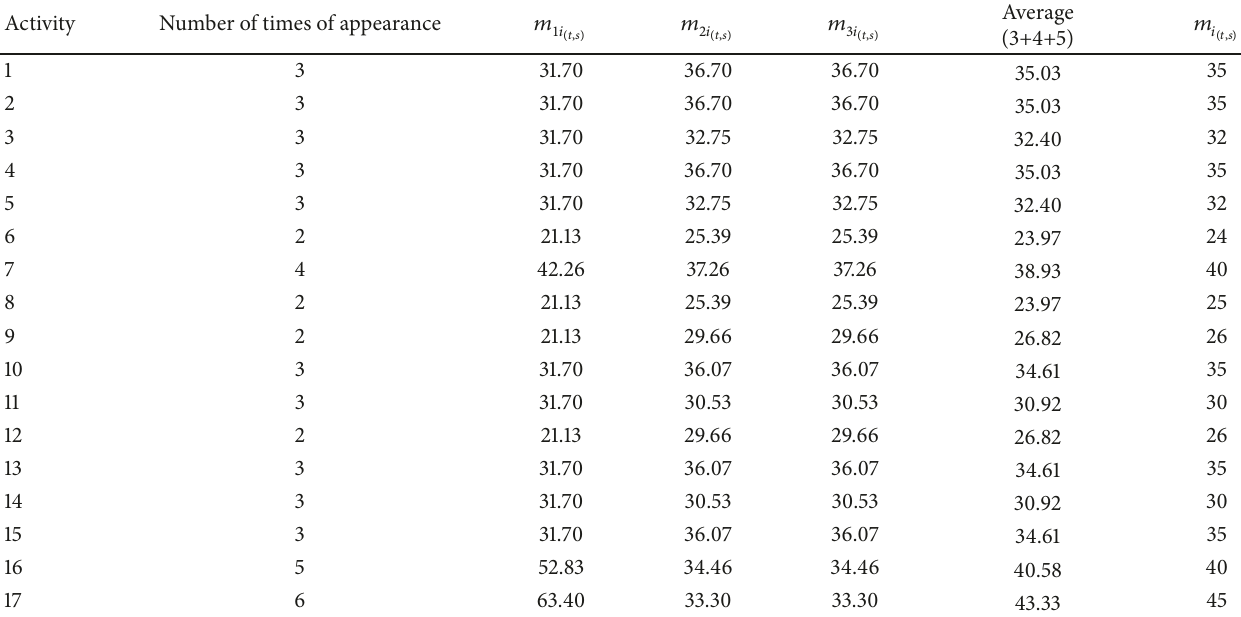
Table 2: Margin reallocation for presented Example (Seconds).